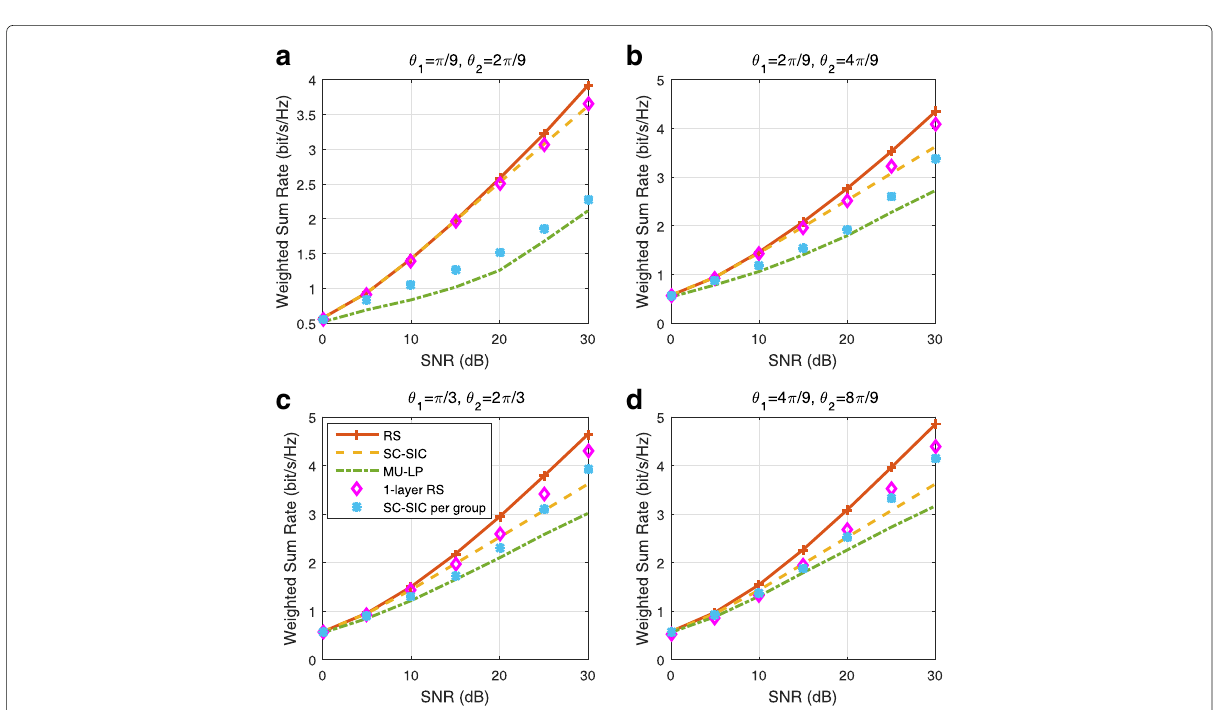
Fig. 55 Weightedsumrateversus SNR comparison of different strategies for overloaded three-user deployment with imperfect CSIT, γ 1 = 1, γ 2 =